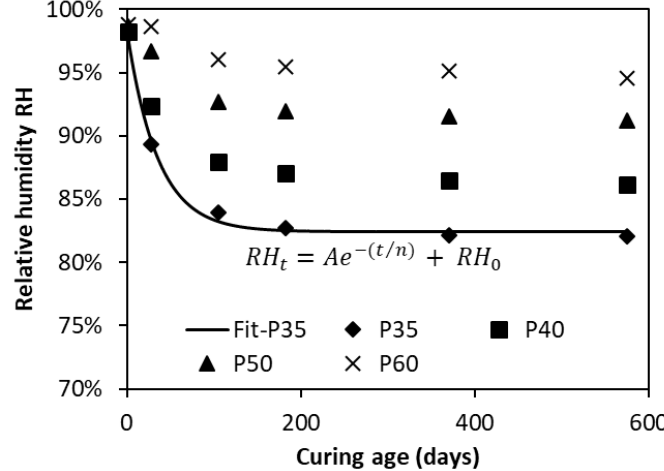
Figure 5. Development of relative humidity with cement hydration in OPC pastes.